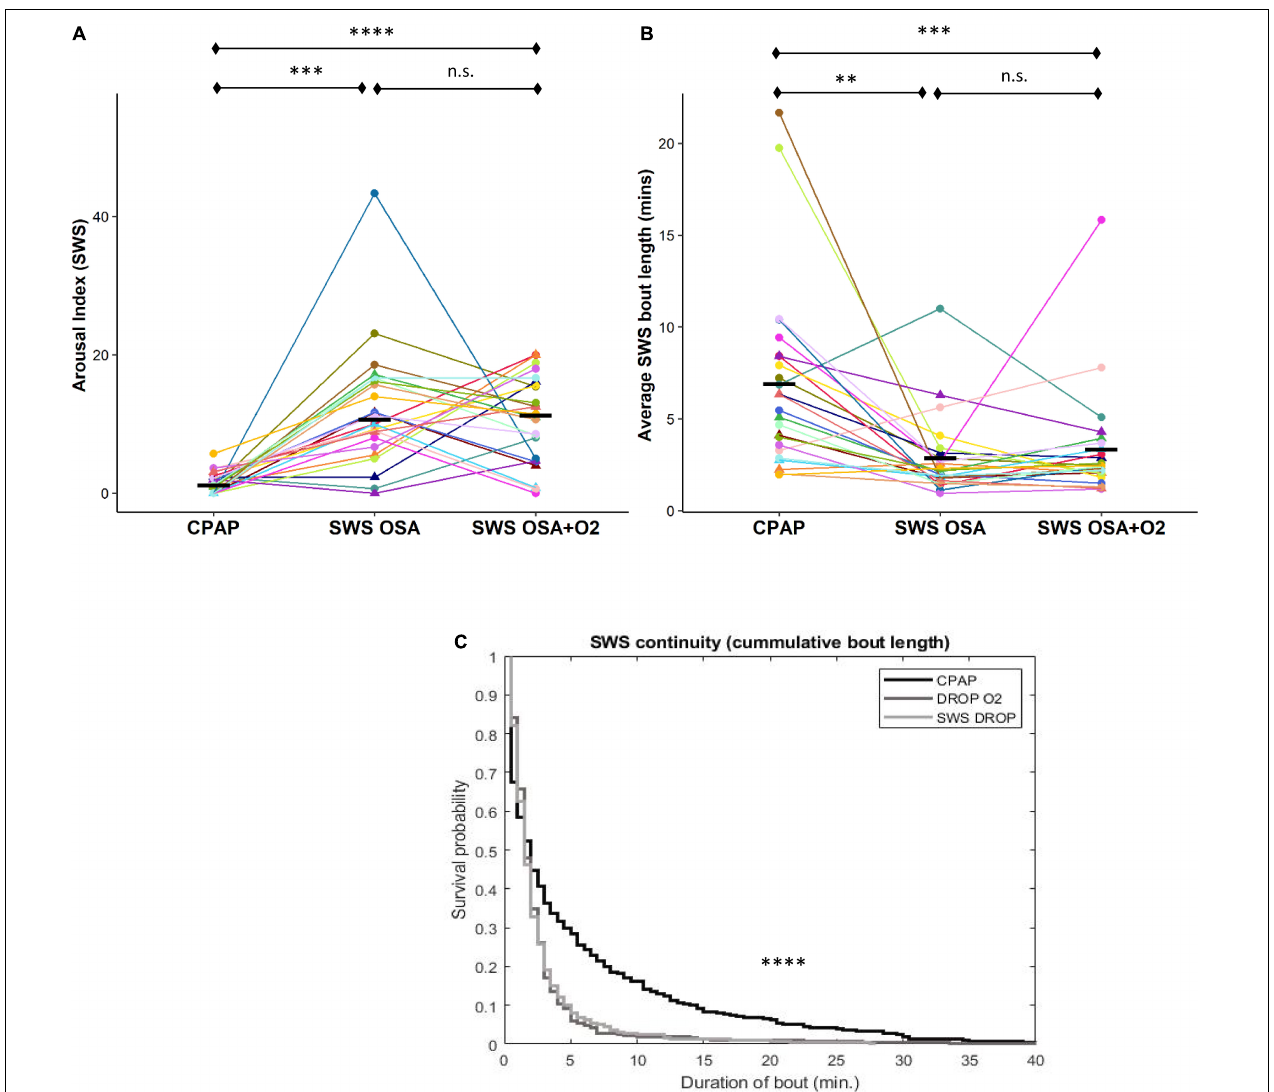
FIGURE 1 | Intermittent withdrawal of continuous positive airway pressure (CPAP) during slow-wave sleep (SWS) results in increased arousals, shorter sleep bouts, and less sleep continuity. Sleep fragmentation (SF) during SWS, according to the arousal index (a), was significantly greater during OSA SWS and OSA SWS + O2 conditions compared to CPAP. Significantly reduced sleep continuity, corresponding to shorter mean (b) and cumulative bout lengths (c), was also observed during OSA SWS (light gray) and OSA SWS + O2 (dark gray) compared to the CPAP (black line) condition. In (a,b), all 24 participants are represented by different colors with a triangle indicating female. Median values for each condition are shown as a solid black line. There were no statistically significant differences between OSA SWS and OSA SWS + O2 for any measure of SF. n.s., not significant; ∗∗∗∗ p < 0.0001, ∗∗∗ p < 0.001, ∗∗ p < 0.01 and ∗ p < 0.05.